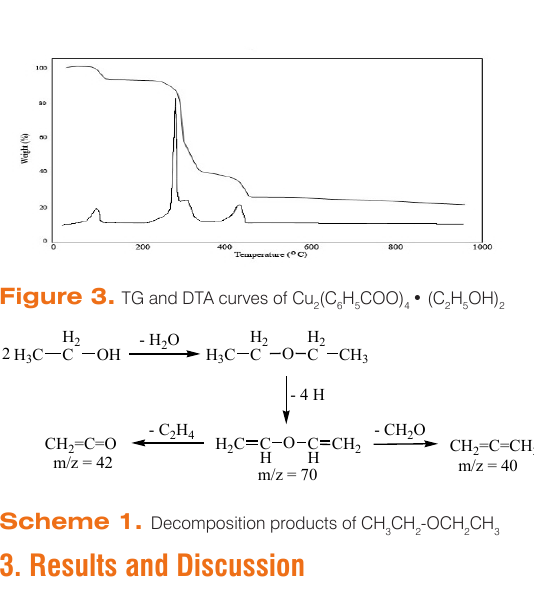
Figure 2. Dimeric and paddle-wheel structure of copper(II) benzoate with ethanol at the axial positions